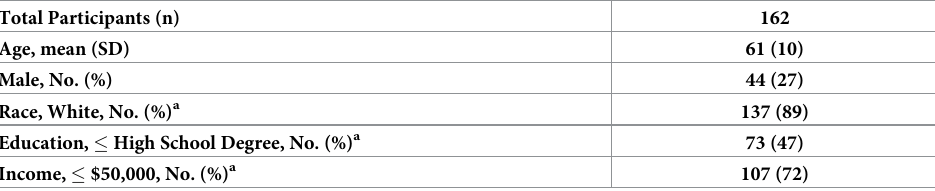
Table 1. Demographic characteristics for the Silicone Arthroplasty in Rheumatoid Arthritis Cohort.